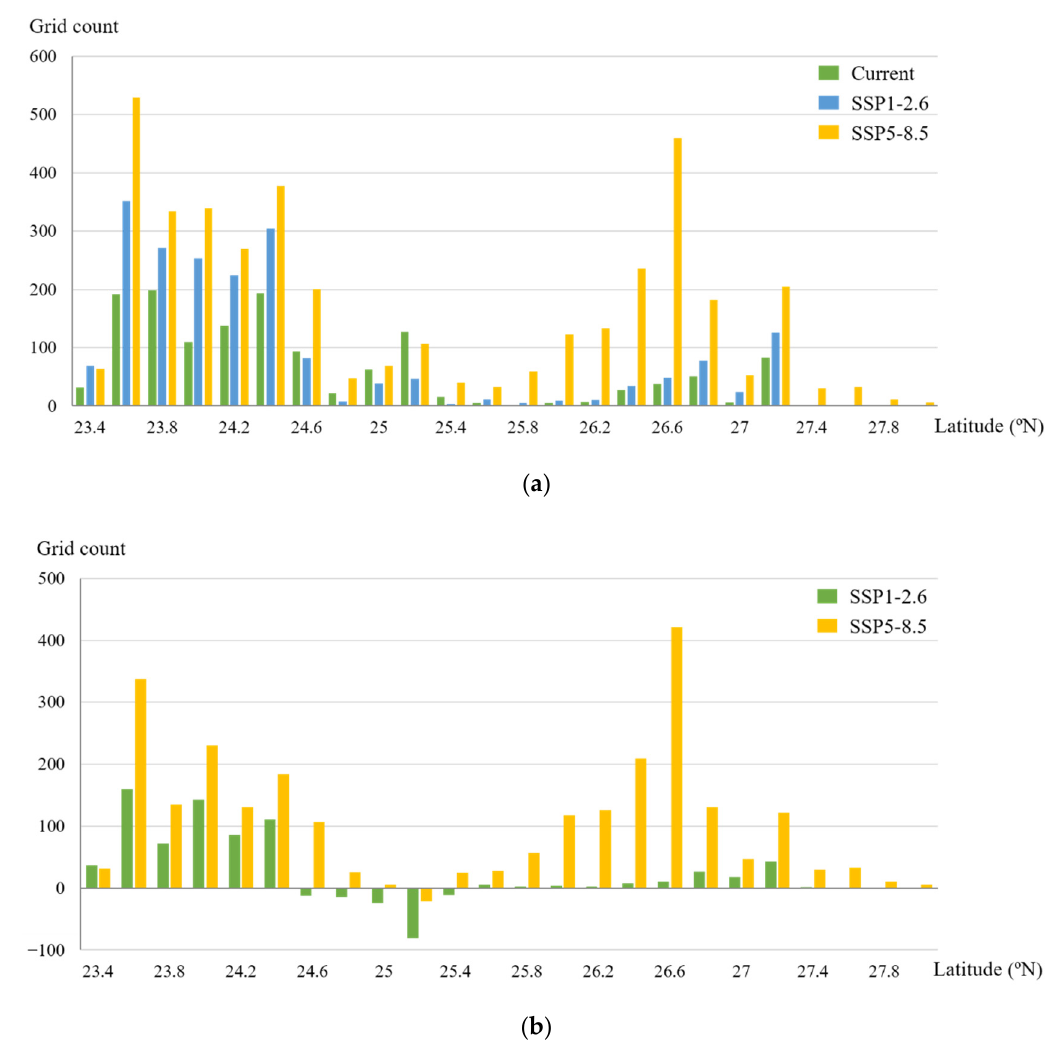
Figure 6. Distribution and variation of current and future mangrove suitable habitats along latitude gradients: ( a ) distribution; ( b ) variation.